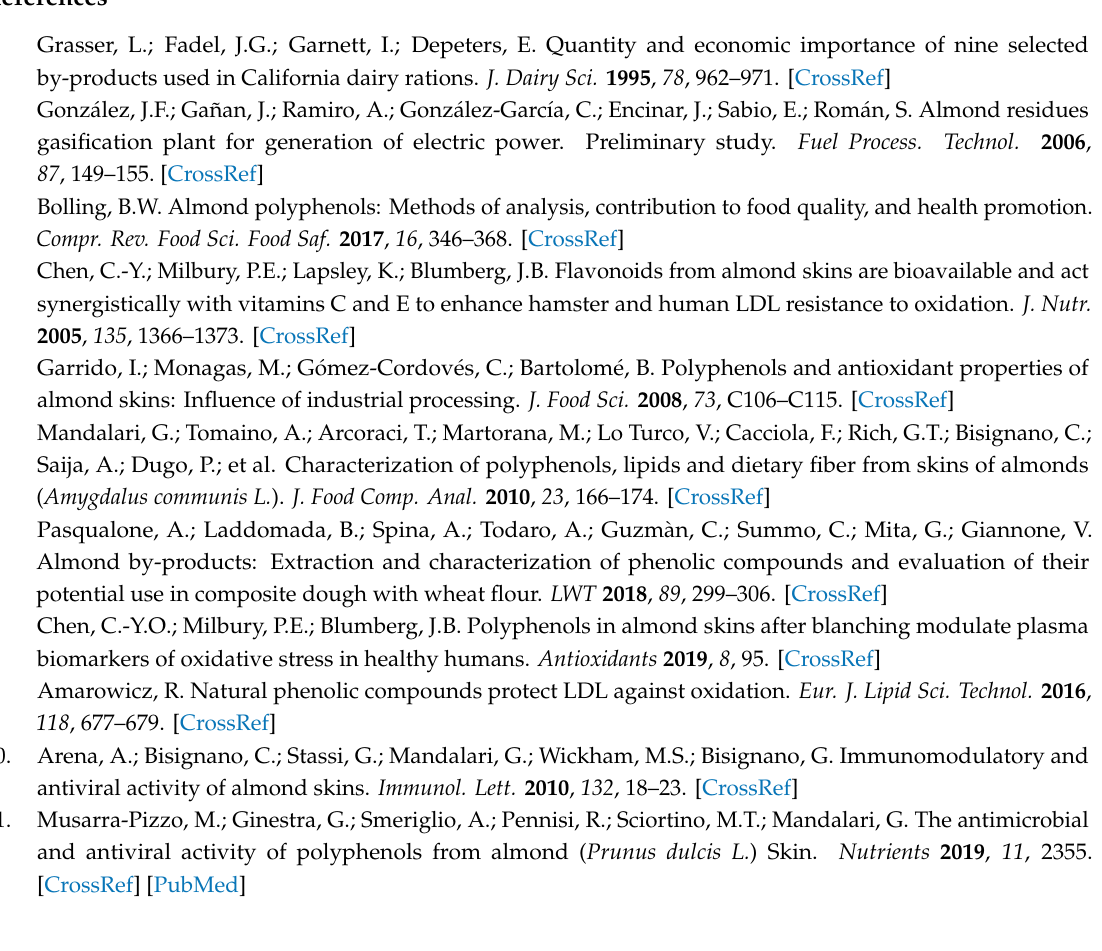
Table S1: Regression equation, linear range, correlation coe ffi cient ( R 2 ), limit of detection (LOD), and limit